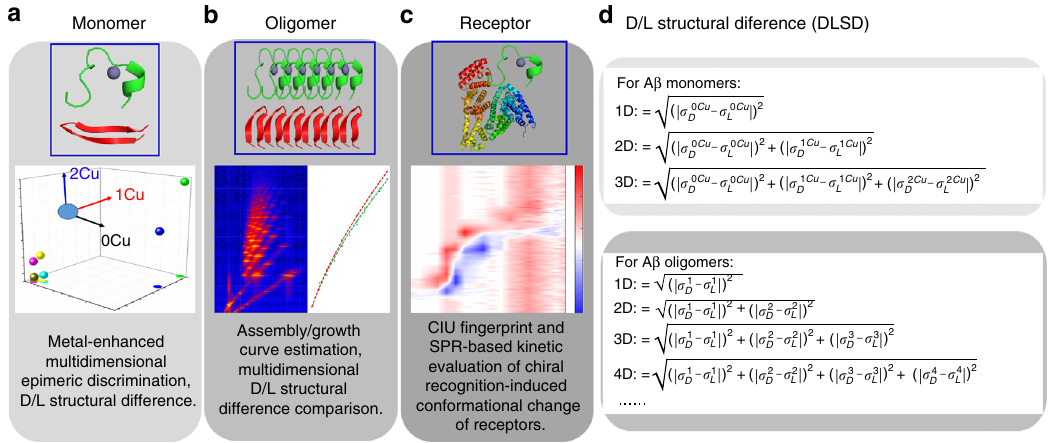
Fig. 1 The overall conception of iCAP. a Metal-enhanced multidimensional epimeric discrimination is used to amplify the D/L structural differences (DLSDs) of A β monomers. b Discrimination of chiral A β fragment oligomers by assembly/growth curve based multidimensional DLSD comparisons. c Elucidation of chiral A β -receptor recognition by CIU fi ngerprint and SPR-based kinetic evaluation. d The calculation equations for DLSD. σ 0 Cu D / σ 0 Cu L : CCS values of apo-A β fragment; σ 1 Cu D / σ 1 Cu L : CCS values of [A β + Cu(II)] complex; σ 2 Cu D / σ 2 Cu L : CCS values of [A β + 2Cu(II)] complex. σ 1 D / σ 1 L / σ 2 D / σ 2 L / … σ n D / σ n L : CCS values of A β oligomers (aggregation number = n ). All charge states were considered during DLSD